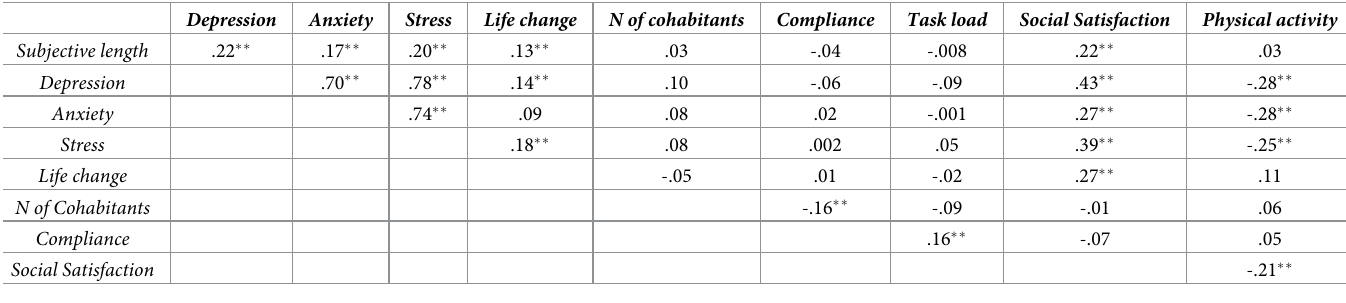
Table 2. Spearman’s correlation coefficients for the relationship between the perceived length of the year, affect, number of cohabitants, task load and compliance, social satisfaction and physical activity. Depression Anxiety Stress Life